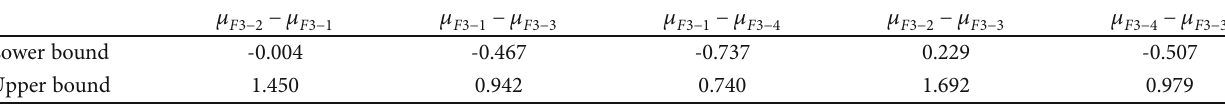
Table 10: Con fi dence interval data of mean in the F3 index.